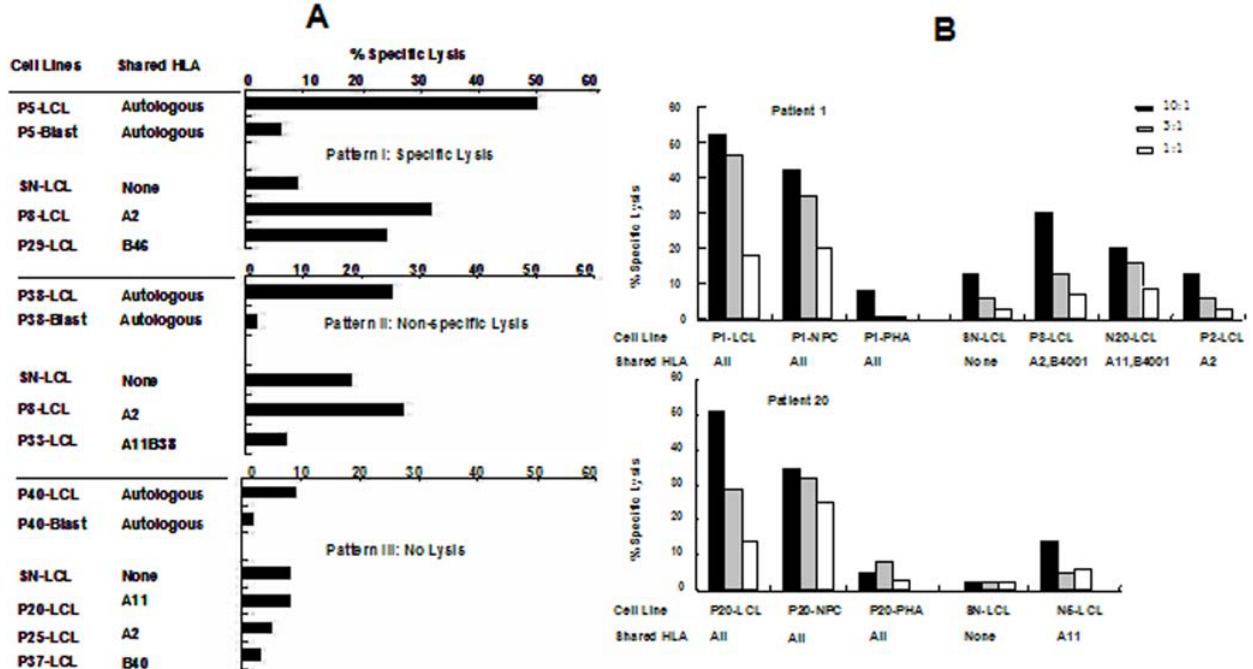
Figure 4. Cytotoxic activity of auto-LCL activated cultures from PBMCs of NPC patients. Polyclonal CTL cultures were test for cytotoxic activity against a panel of targets including the autologous EBV transformed LCL, PHA blasts, allogenic HLA class I matched or mismatched LCL. A. Representative experiments illustrating three pattern of cytotoxic activity. Pattern I: Lysis of the auto-LCL $ 25% and HLA class I mismatched LCL # 10%; Pattern II: lysis to both HLA class I matched and mismatched LCL; Pattern III: less than 10% lysis against autologous or allogenic EBV positive or negative targets B. EBV-specific CTL cultures from NPC patients lysed freshly isolated autologous NPC tumor cells. Representative 51 Cr release assays performed with CTL cultures from two NPC patients are shown in the figure.